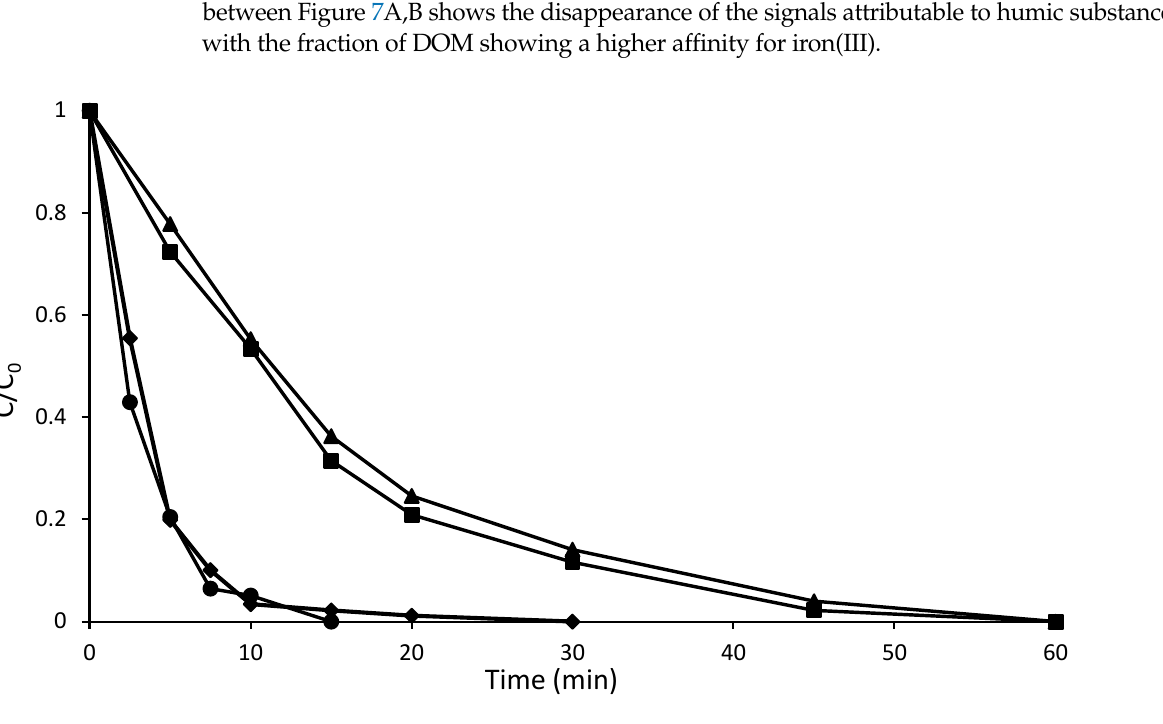
Figure 10. Influence of the photo-Fenton process in c-f-WWTP2 under UVC irradiation ( ▲ ), the addition of 0.02 mM of Fe(II) ( ■ ), the addition of 21 mM of H 2 O 2 ( ), and the addition of 0.02 mM of Fe(II) and 21 mM of H 2 O 2 ( ● ).